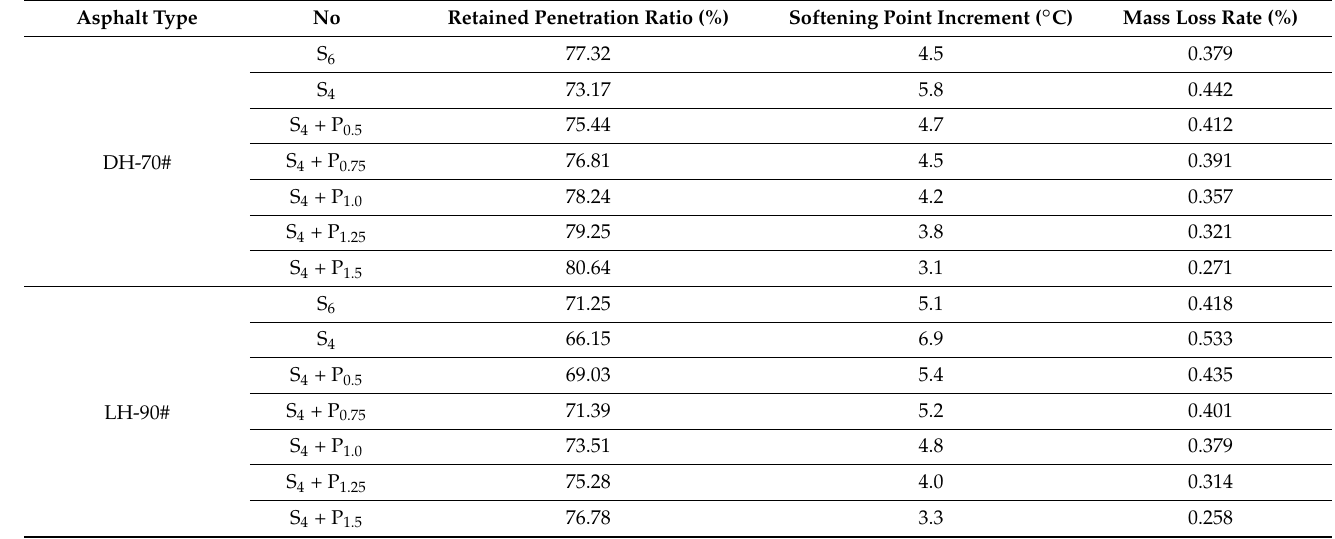
Table 6. Performance changes of PPA–SBS modified asphalt before and after aging.